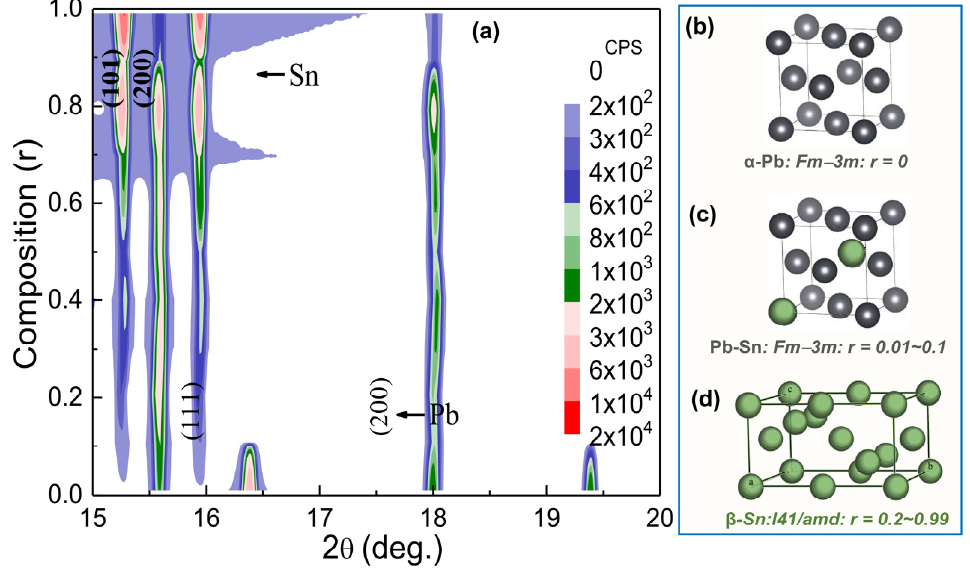
Figure 2. ( a ) a 2D plot of XRD patterns of Sn r Pb 1-r bimetallic nanoalloys over a narrow range of scattering angle 2 θ ; the crystalline structure of ( b ) α -Pb; ( c ) α -Pb/Sn solid solution; and ( d ) β -Sn, respectively.